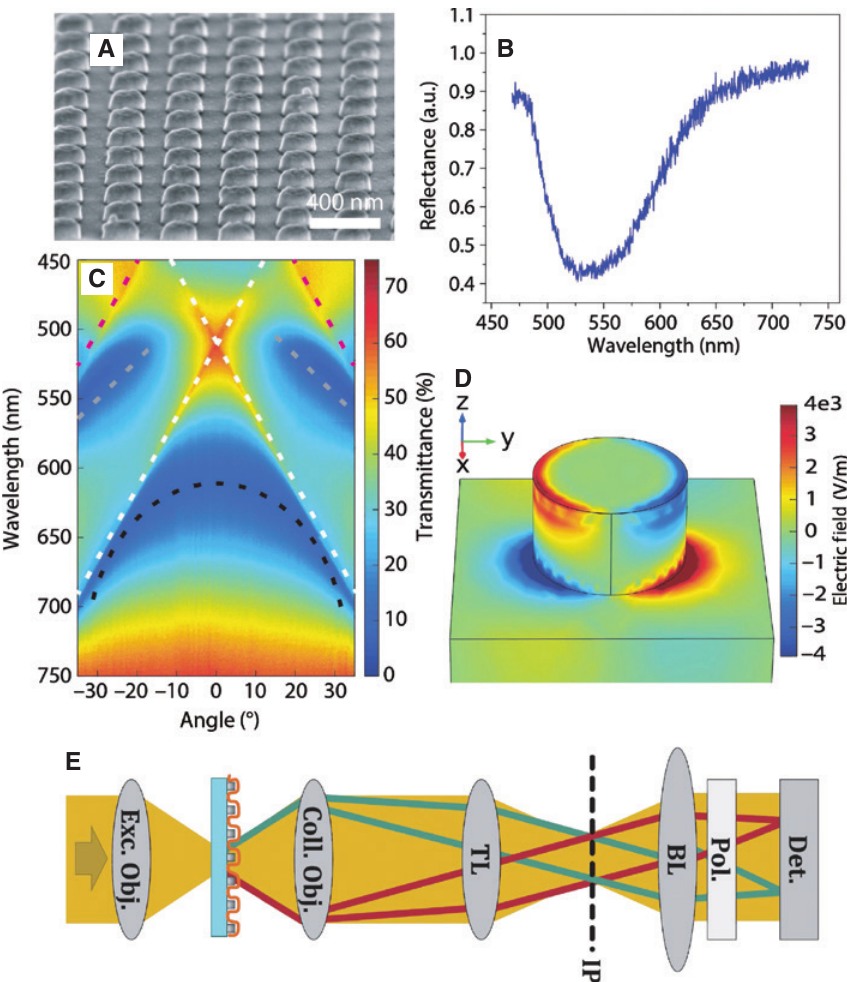
Figure 1: Ag nanopillar arrays and supported optical modes. (A) A tilted scanning electron microscopy (SEM) image of a bare array of silver nanopillars (345 nm pitch and 150 nm pillar diameter). (B) Reflectance spectrum from a single pillar from a confocal collection spot. (C) The measured angle-resolved transmission spectrum of the pillar geometry in (A) for p -polarized transverse magnetic (TM) incident light. White and red (black and grey) dotted lines corresponding to the RA (SLR) modes. (D) The simulated E -field mode plot for the array in (A) of the out-of-plane SLR mode at an angle of 25 o and wavelength y of 655 nm. (E) The schematic diagram showing the Fourier microscope used to capture the angle-resolved spectra in (C) and Figure 4. The Bertrand lens (BL) is placed after the tube lens (TL) to form an angle-resolved (signified by the green and red traces) Fourier image at the slit of the detector